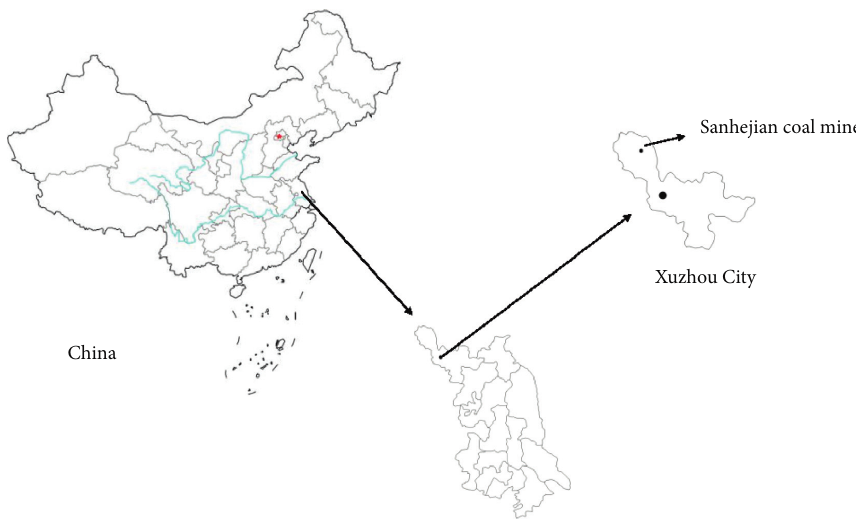
Figure 1: Location of Sanhejian coal mine.